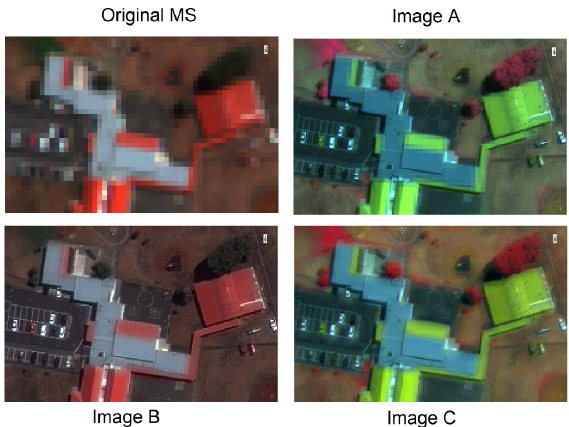
Figure 3. Image example for questionnaire; Images A-C are fused images using three different pansharpening algorithms (Fries 2017)